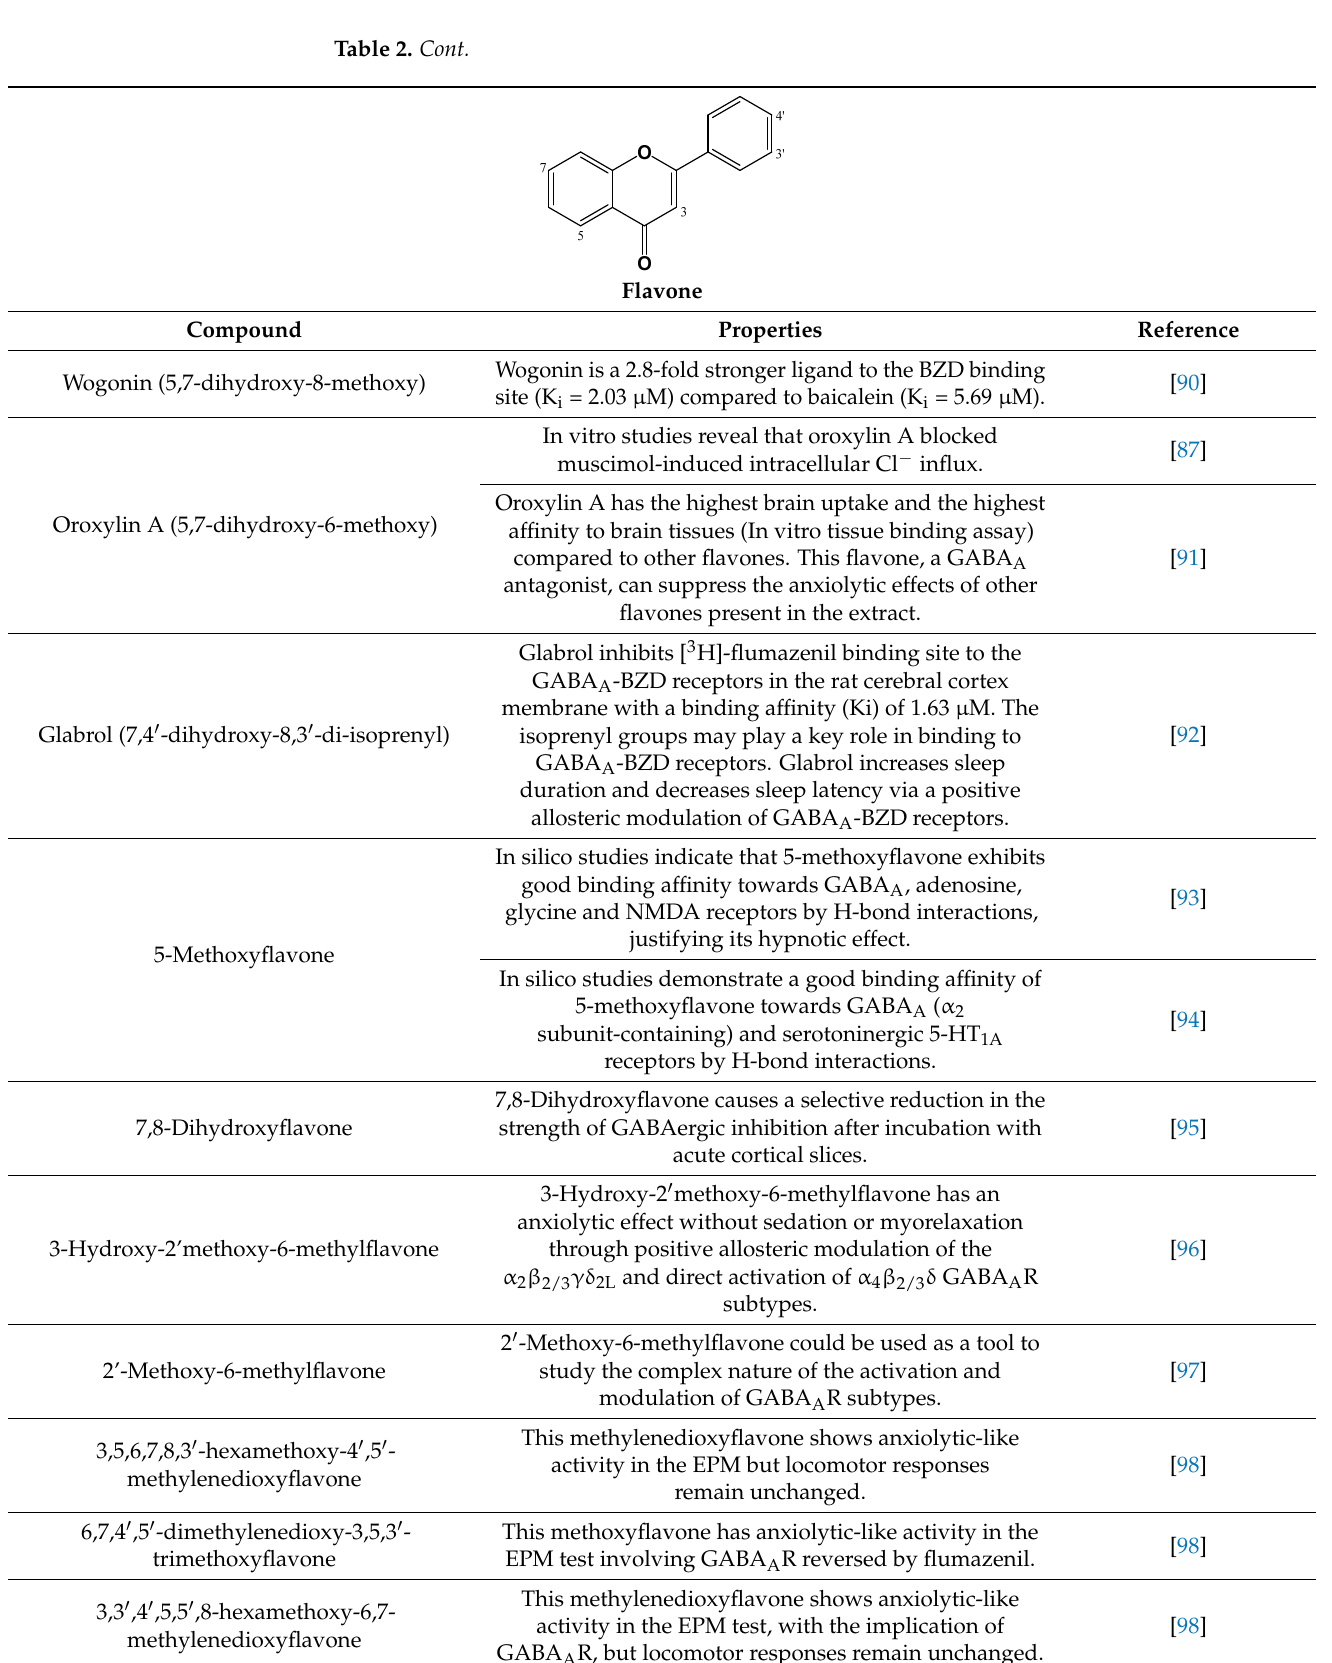
Table 2. Flavones with relevant GABAergic effects. Aβ (β-amyloid), APP (amyloid precursor pro- Table 2. Cont. kinase), REM (rapid eye movement), SW (slow